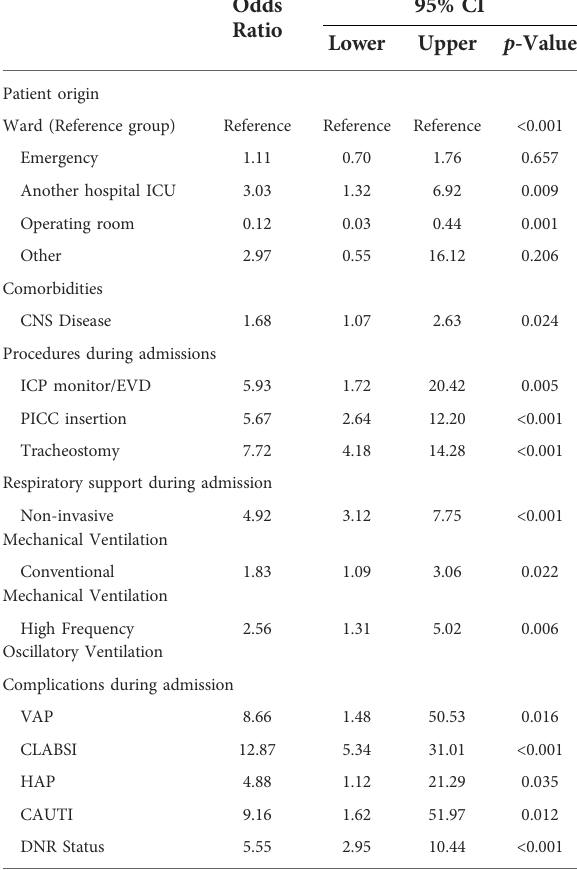
TABLE 4 Multivariate analysis according to the length of stay